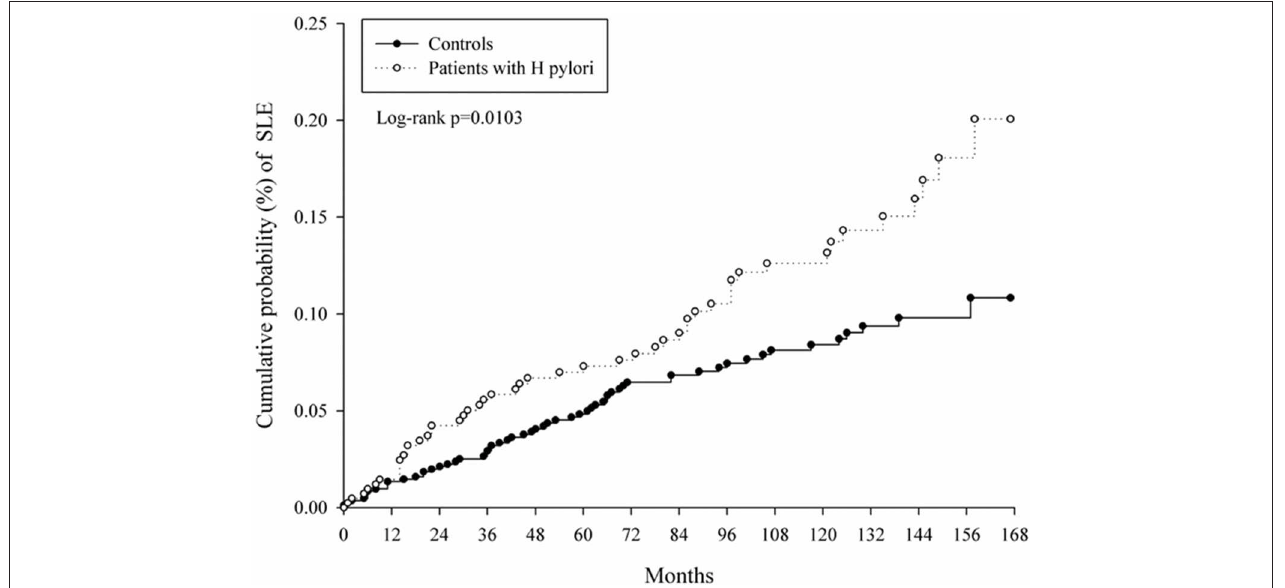
FIGURE 2 | Kaplan–Meier curves of cumulative probability of systemic lupus erythematosus (SLE) in study